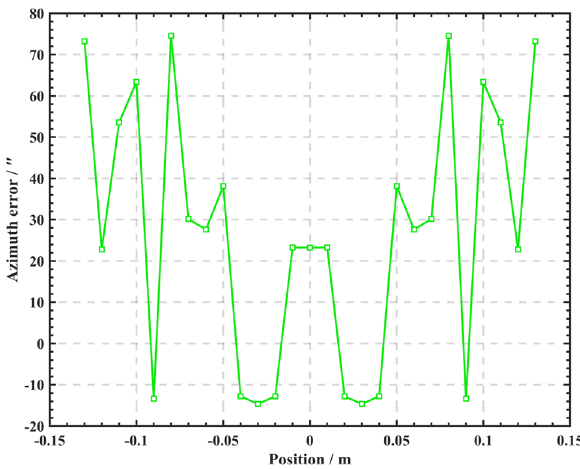
Figure 7. Azimuth transmission error